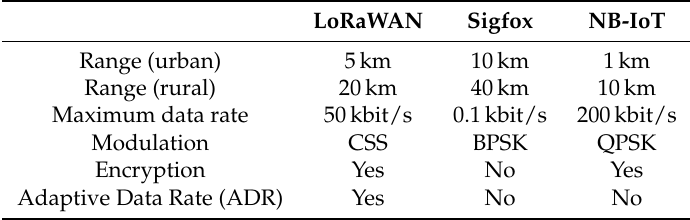
Table 2. Comparison of different Low-Power Wide Area Network (LPWAN) technologies [34]. All technologies listed support bi–directional communication, the standard for each technology is driven by different organisations. The different modulation schemes used are Chirp Spread Spectrum (CSS), Binary Phase Shift Keying (BPSK) and Quadrature Phase Shift Keying